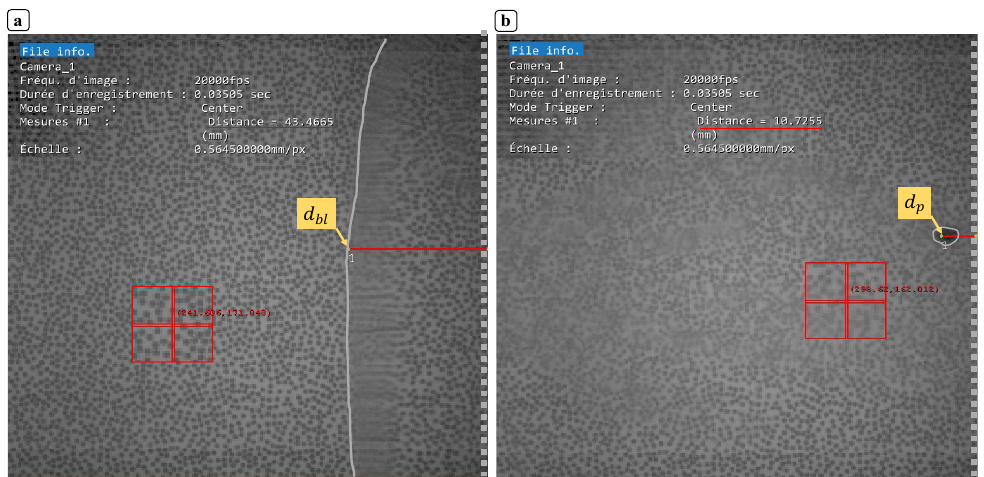
Figure 12. Extract from the PFV software for the measurements of: ( a ) position of the blast wave front after its first appearance in the FOV, ( b ) position of the projectile after its first appearance in the FOV. (See test 11 in Table 1).